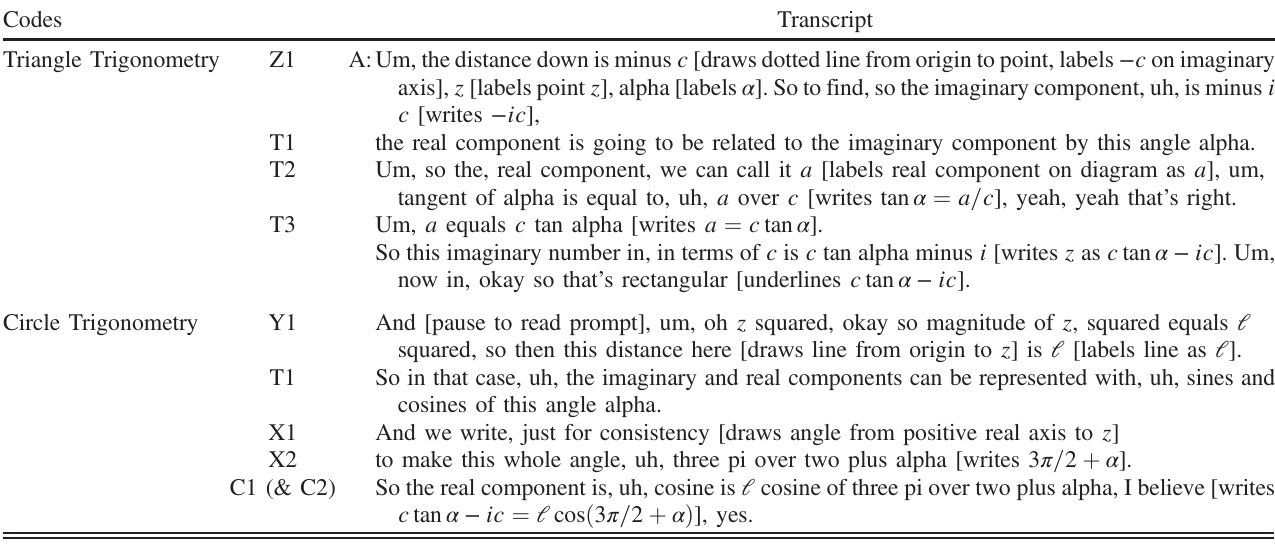
TABLE IV. Example of the coding for a portion of student A ’ s interview during part (a). The excerpt corresponds to the first two upper boxes in Fig. 3 for student